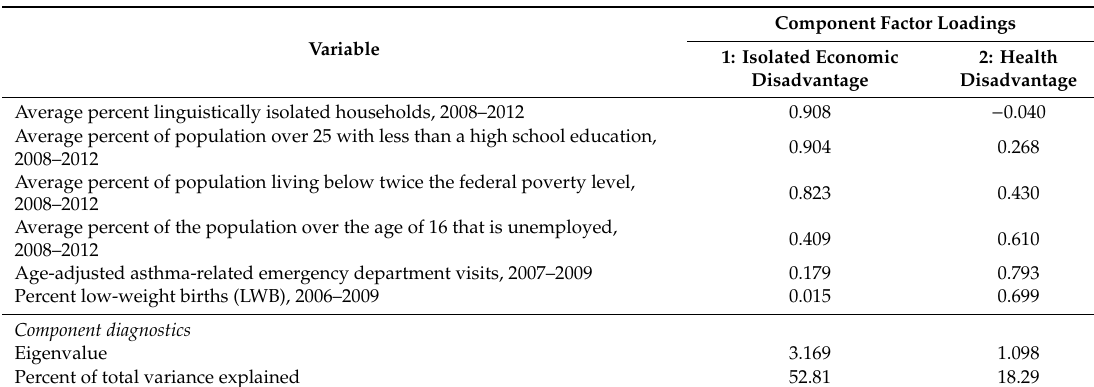
Table2. PrincipalcomponentanalysisresultsforCalEnviroScreen2.0extrinsicandintrinsicvulnerability indicators ( N = 7610 tracts) 1